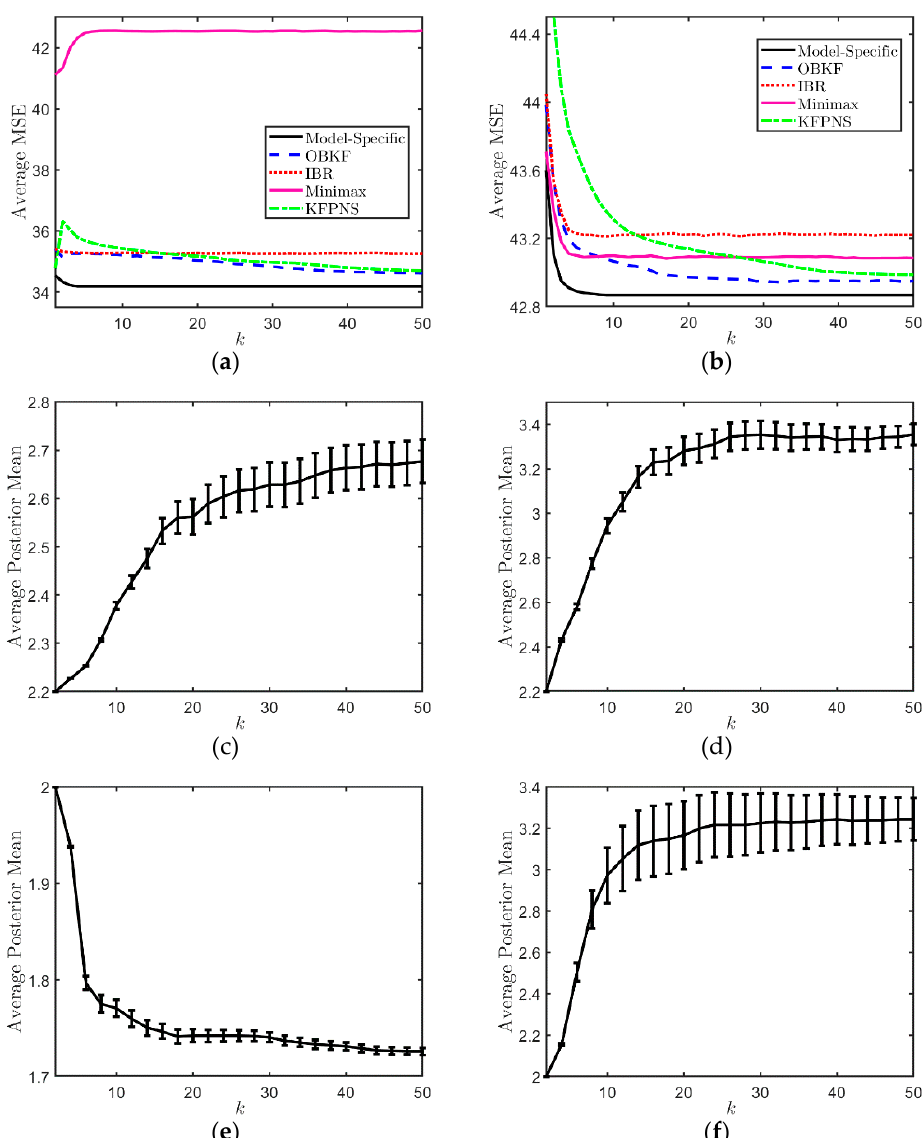
Figure 4. Performance analysis for specific noise pairs. ( a ) The average MSE for specific noise model α 1 = 3, α 2 = 1.5. ( b ) The average MSE for specific noise model α 1 = 3.5, α 2 = 3.5. ( c ) The variation of E [ α 1 |Y k ] and its variance when α 1 = 3. ( d ) The variation of E [ α 1 |Y k ] and its variance when α 1 = 3.5. ( e ) The variation of E [ α 2 |Y k ] and its variance when α 2 = 1.5. ( f ) The variation of E [ α 2 |Y k ] and its variance when α 2 =